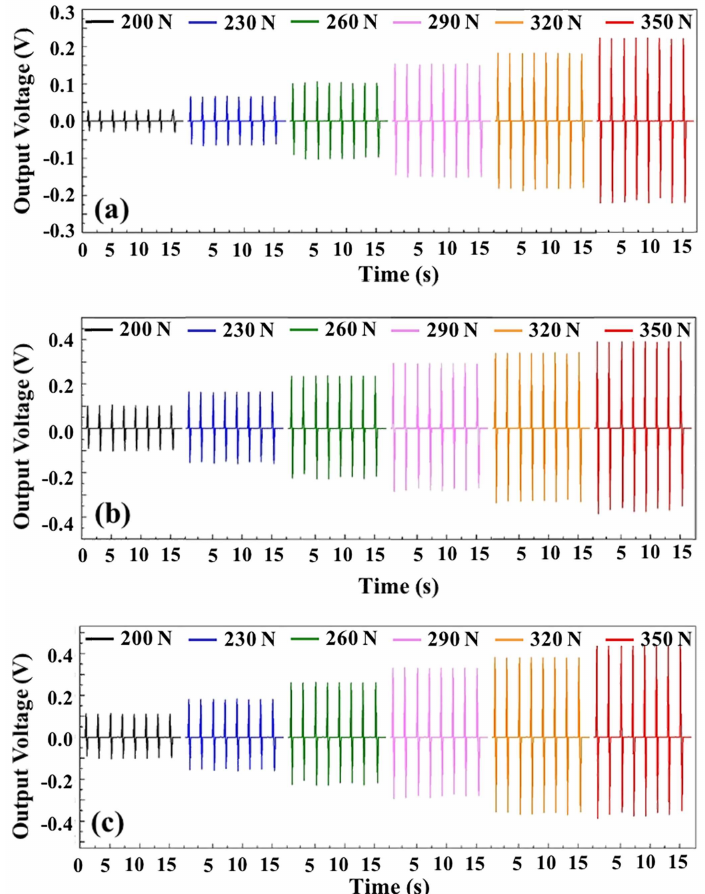
Figure 4. Piezoelectric output voltage waves of the piezoelectric units with: ( a ) randomly oriented electrospun PVDF; ( b ) aligned electrospun PVDF; and ( c ) aligned electrospun PVDF/CNT under compressive forces from 200 N to 350 N.